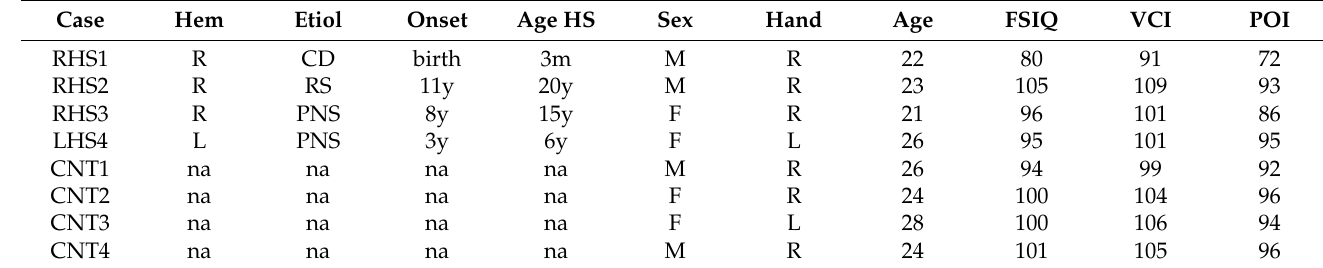
Table 1. Demographic participant information. Hem, hemisphere removed; Etiol, etiology; HS, hemispherectomy; Age HS, age of final hemispherectomy surgery; Onset, onset of epileptic seizures; Hand, handedness; FSIQ, Full Scale Intelligence Quotient; VCI, Verbal Comprehension Index; POI, Perceptual Organization Index; R, right; L, left; CD, Cortical Dysplasia;